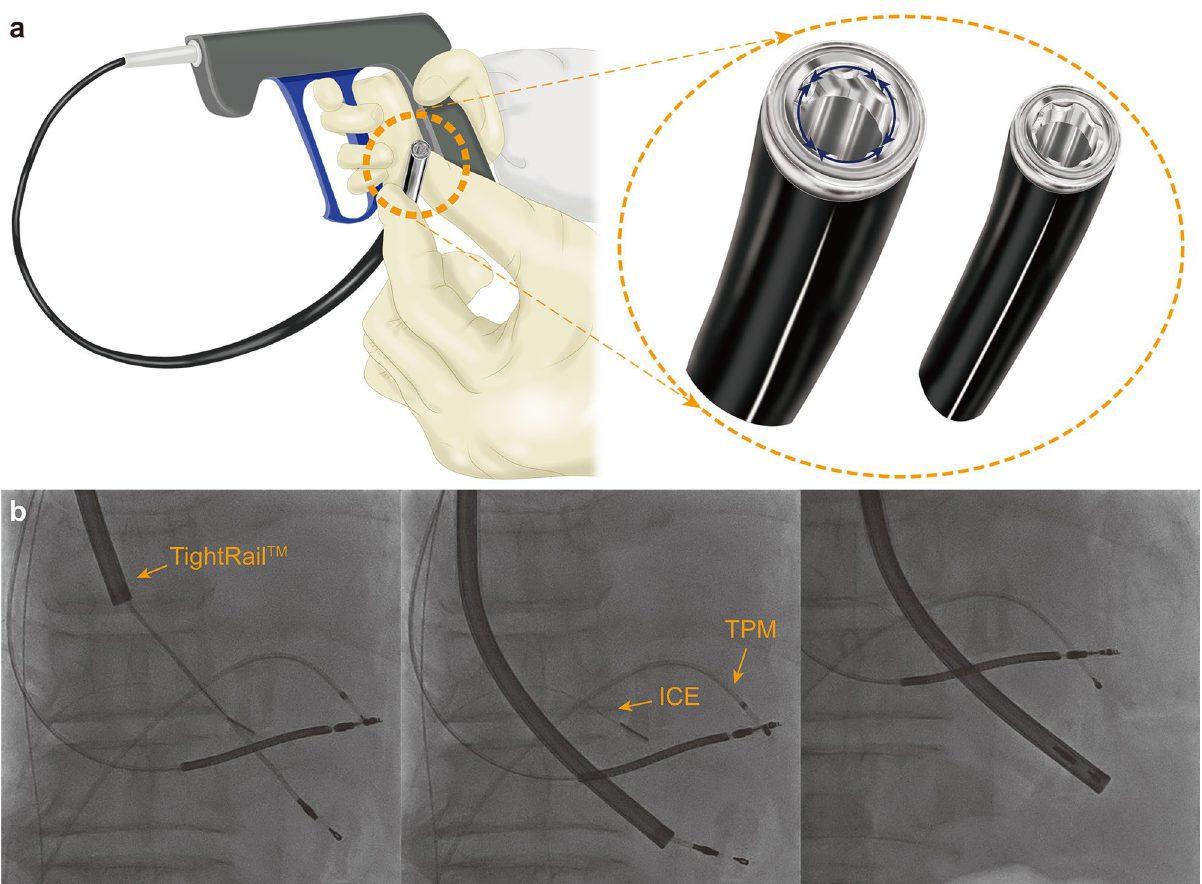
Figure 1. TightRail mechanical dilator sheath with bidirectionally rotating blade ( a ) and serial fluoroscopic image showing TLE procedure using TightRail sheath under ICE and temporary pacing wire backup ( b ). ICE intracardiac echocardiography probe, TLE transvenous lead extraction, TPM temporary